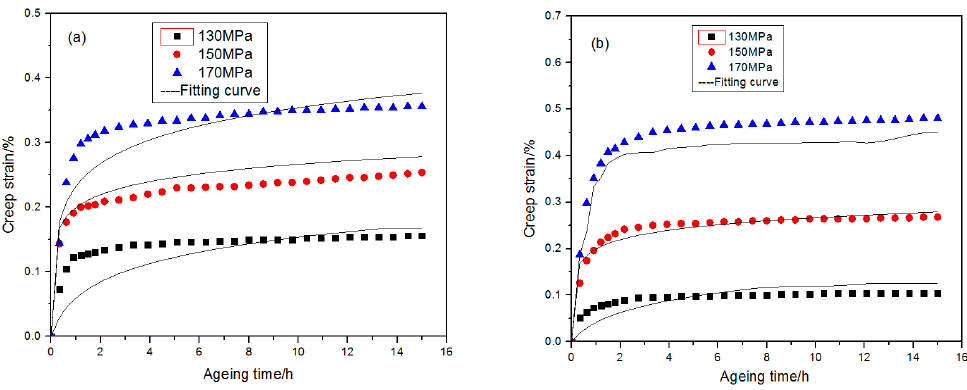
Figure 5. Comparison of fitted values and measured values of 2219 aluminum alloy creep curves at ( a ) 438 K and ( b ) 418 K.